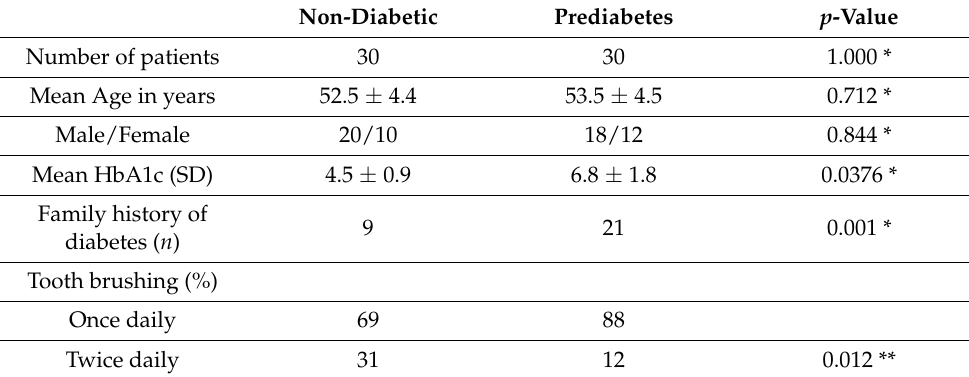
Table 1. Patient